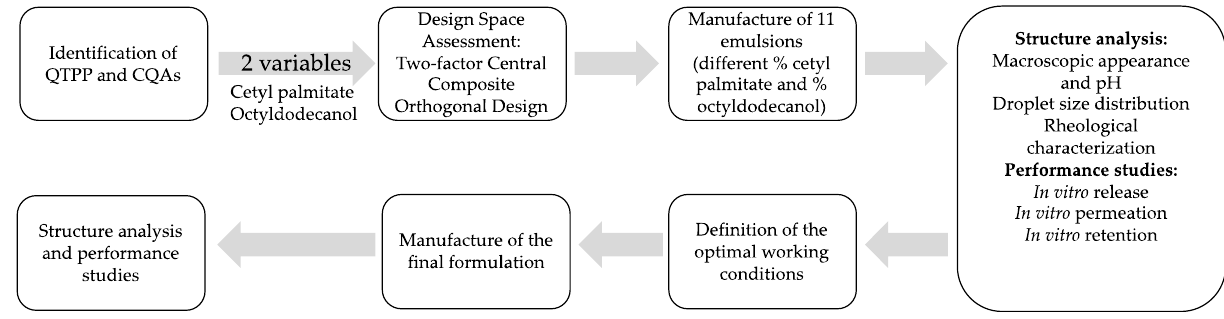
Figure 1. Flowchart including all experimental steps. QTPP—Quality Target Product Profile; CQAs—Critical Quality At- tributes.